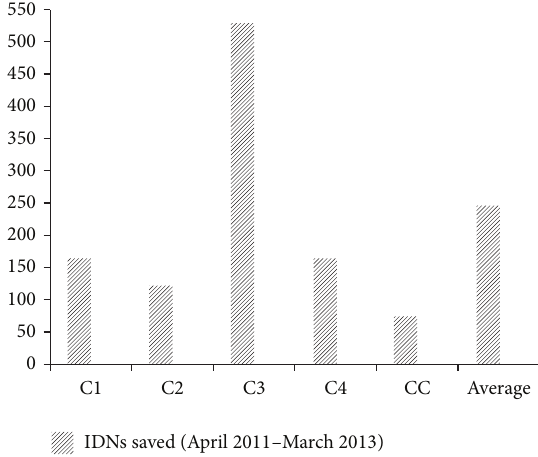
Figure 12: Patient influx. IDN stands for incubator-dependent- neonates.